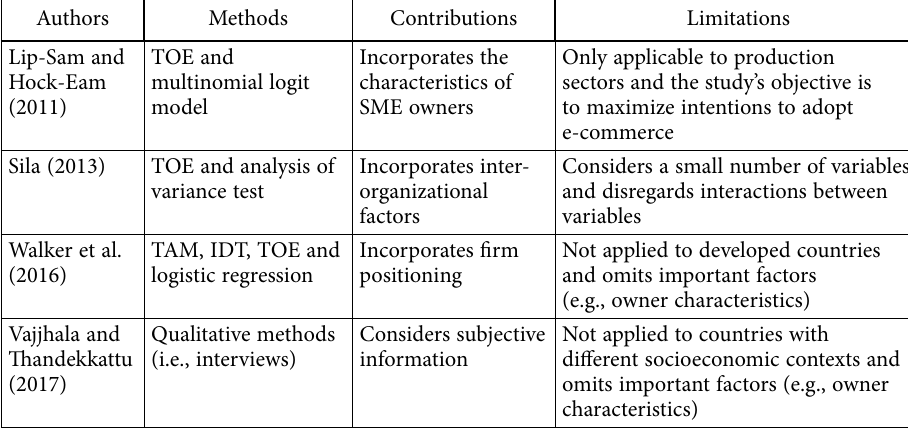
Table 1. Studies related to e-commerce determinants